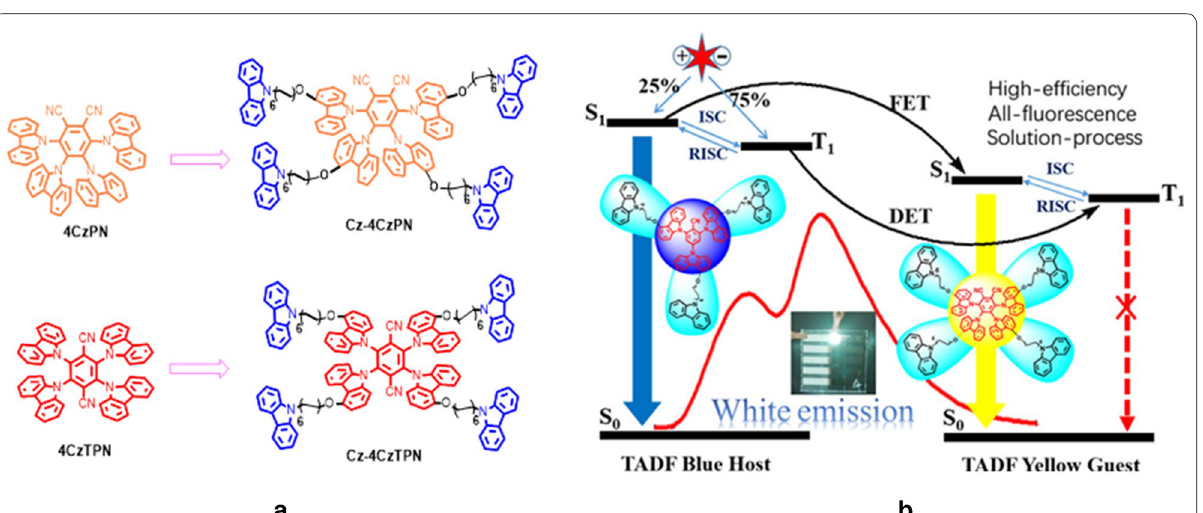
Fig. 17 a Molecular structures of the emitters, b energy transfer mechanism and molecular stacking depiction (Reproduced with permission from Ref. [48] Copyright © 2018, American Chemical